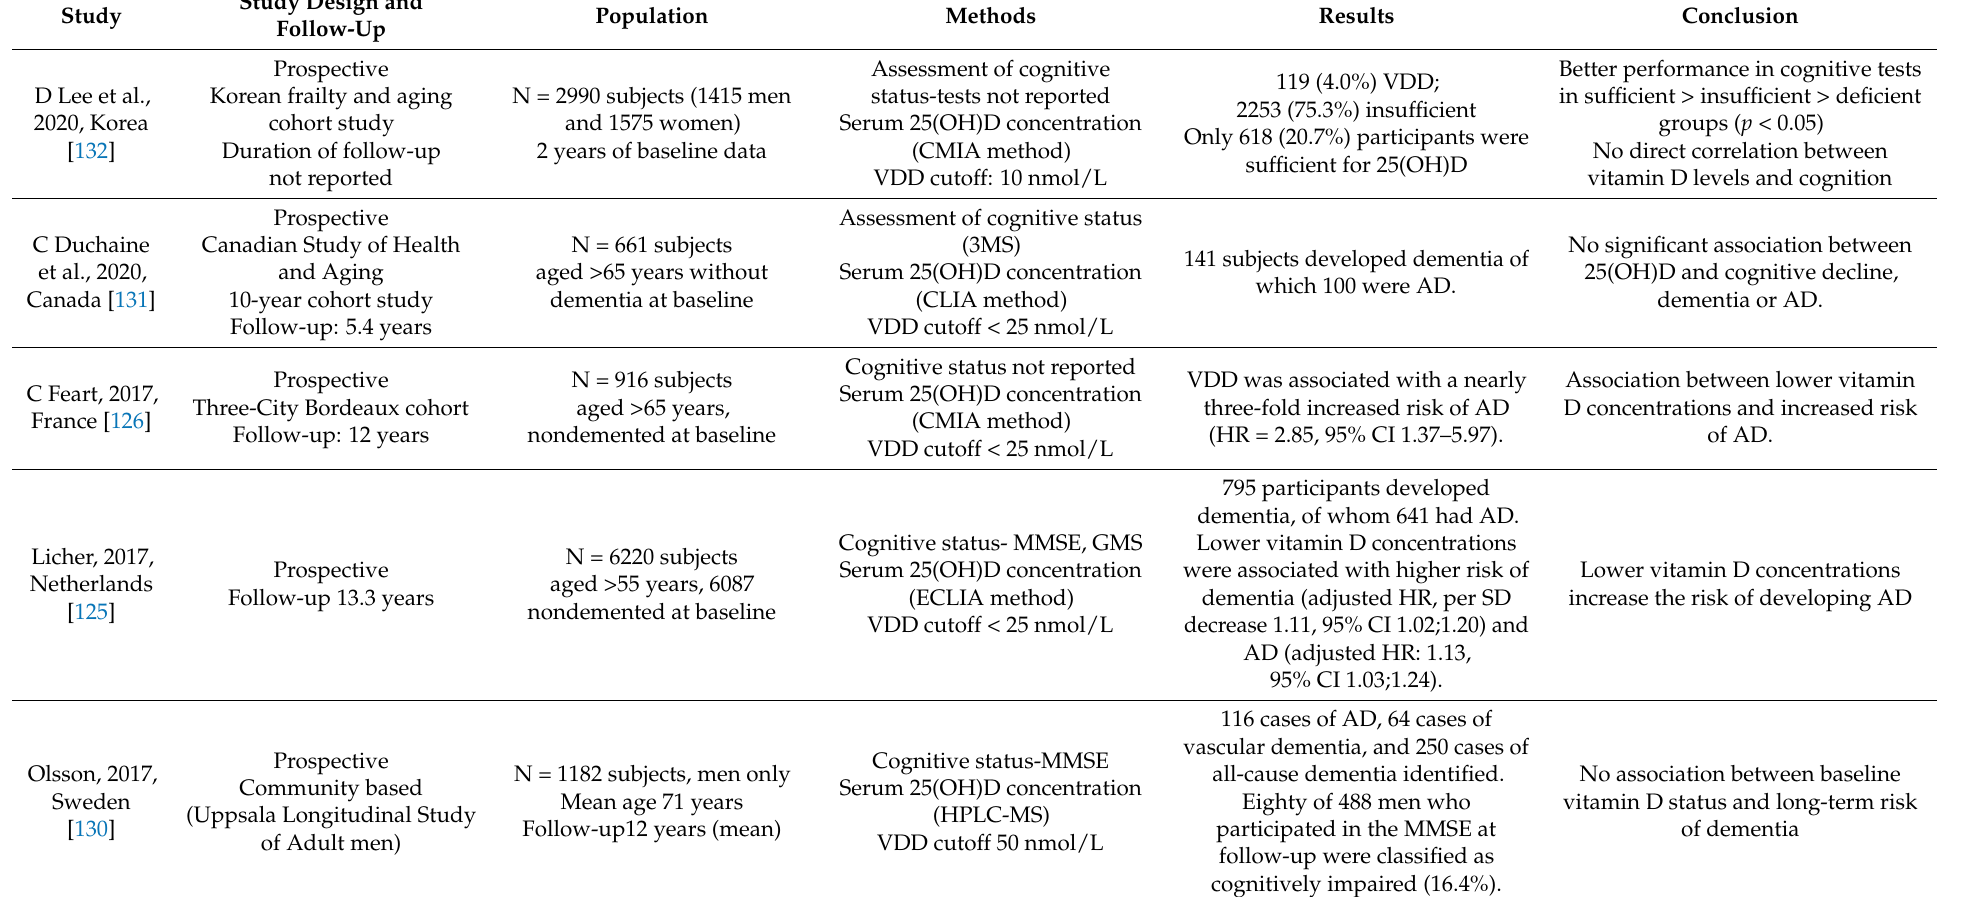
Table 2. Prospective studies on association between vitamin D status and cognitive